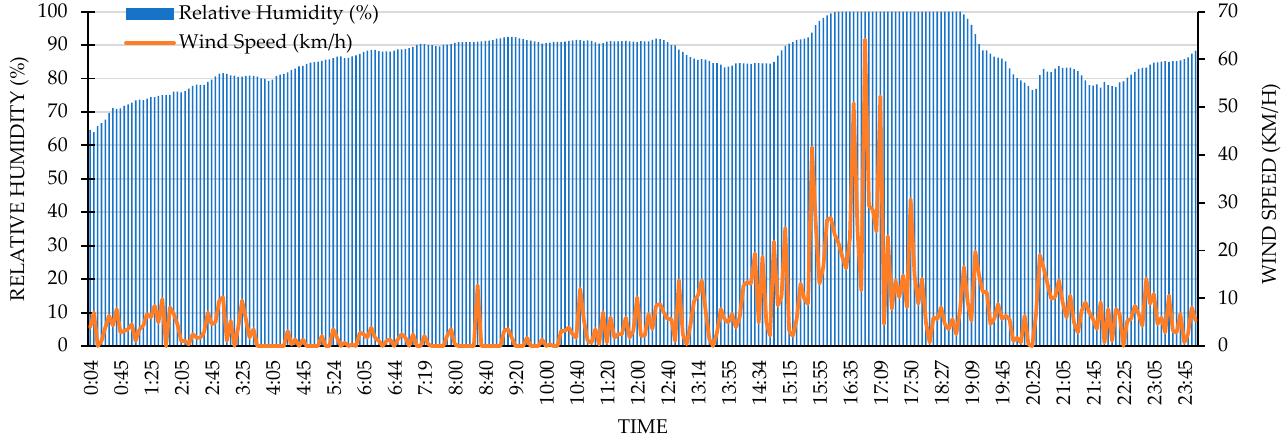
Figure 5. The relative humidity and wind speed data on a typical day.